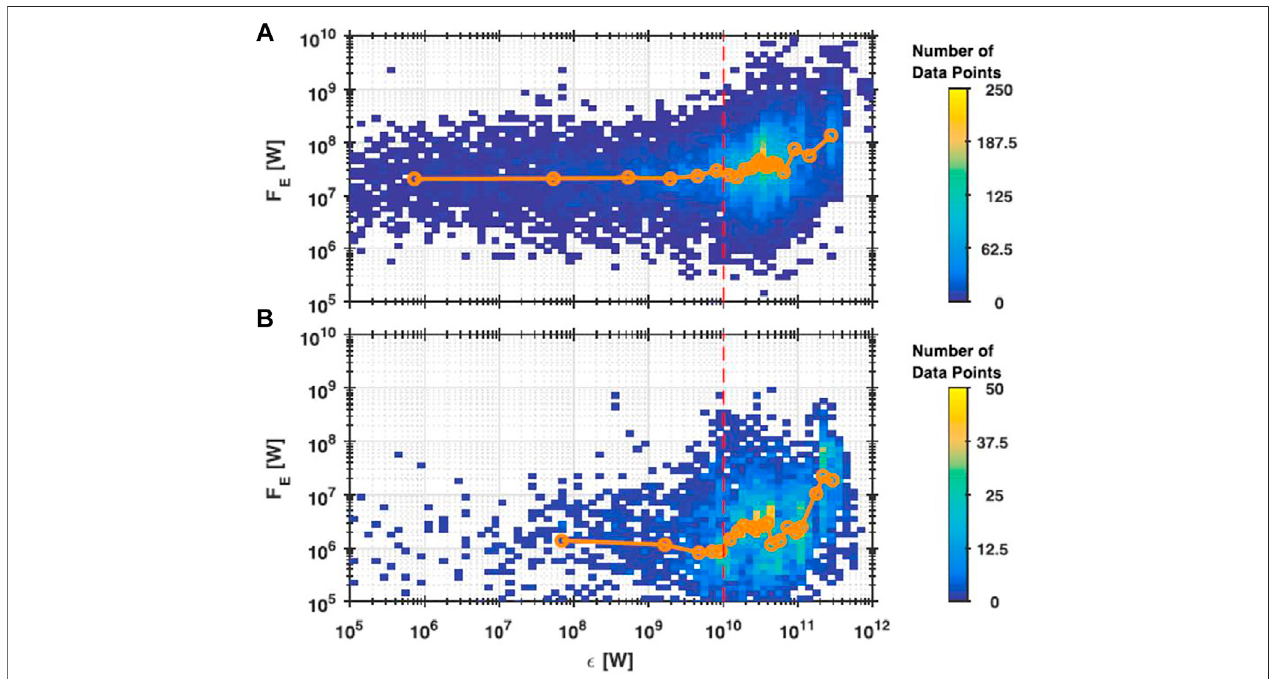
FIGURE6| Totalhemisphericpower,F E, asafunctionofthe ε parameterfortheconditionswheremorethan95%ofthepolarcapissunlit( Figure6A )anddark( Figure6B ), respectively. Colored pixels show the numbers of data points in corresponding ranges of F E and ε parameter. Values indicated by open circles are median values of F E . Under conditions where ε is less than 10 10 W, indicated by the red dash line, solar illumination is considered the main energy source of the cold ion out fl ow. From Li et al., (2018).